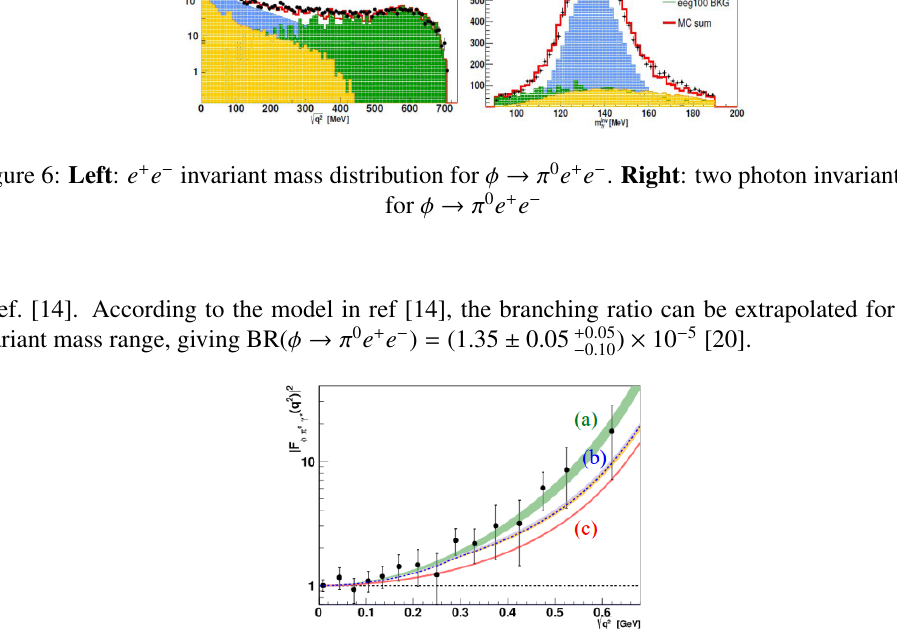
Figure 7: TFF as a function of e + e − invariant mass, compared with the theoretical predictions, (a)chiral theory approach: (green) ref. [14], (b)dispersive analysis: (orange and cyan) ref. [15] and (blue dashed line) ref. [18], (c)one-pole VMD model: